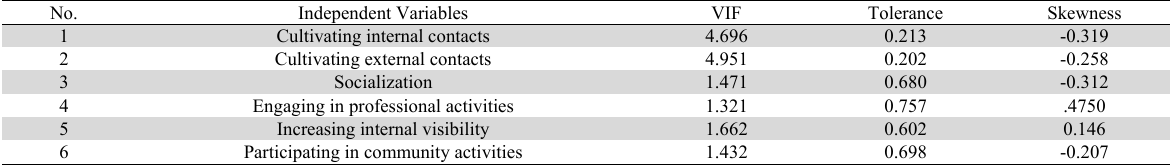
Results of Variance Inflation Factor, Tolerance and Skewness Coefficient